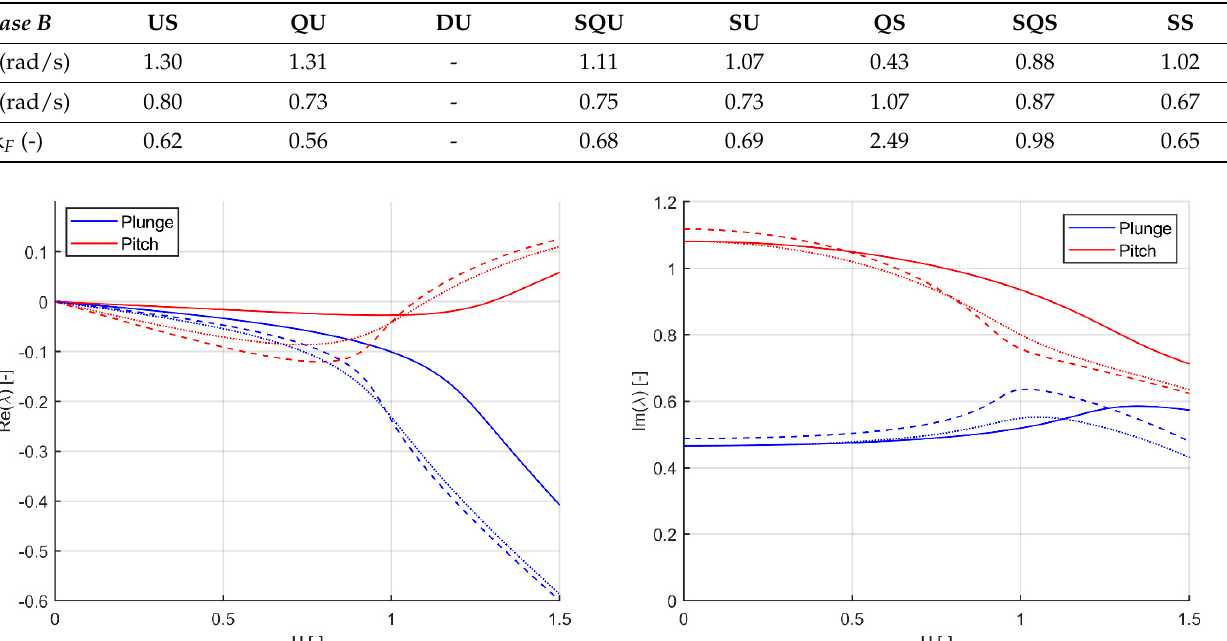
Figure 6. Evolution of the complex eigenvalues for Case B: real part ( left ), imaginary part ( right ); continuous, dashed and dotted lines for QU, QS and SQS aerodynamic models, respectively.